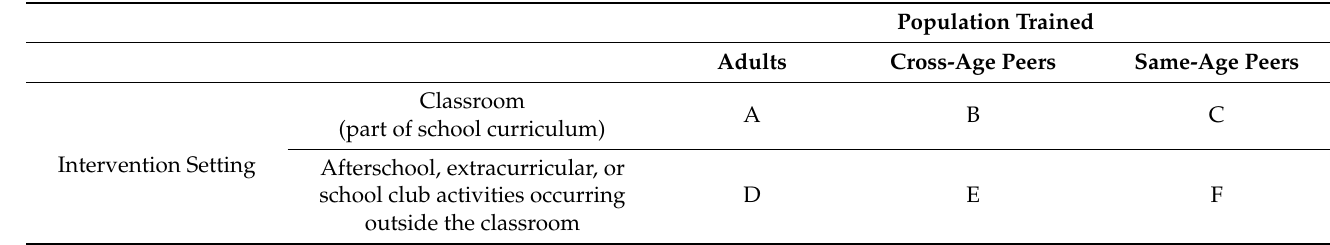
Table 1. Framework for categorizing nutrition education